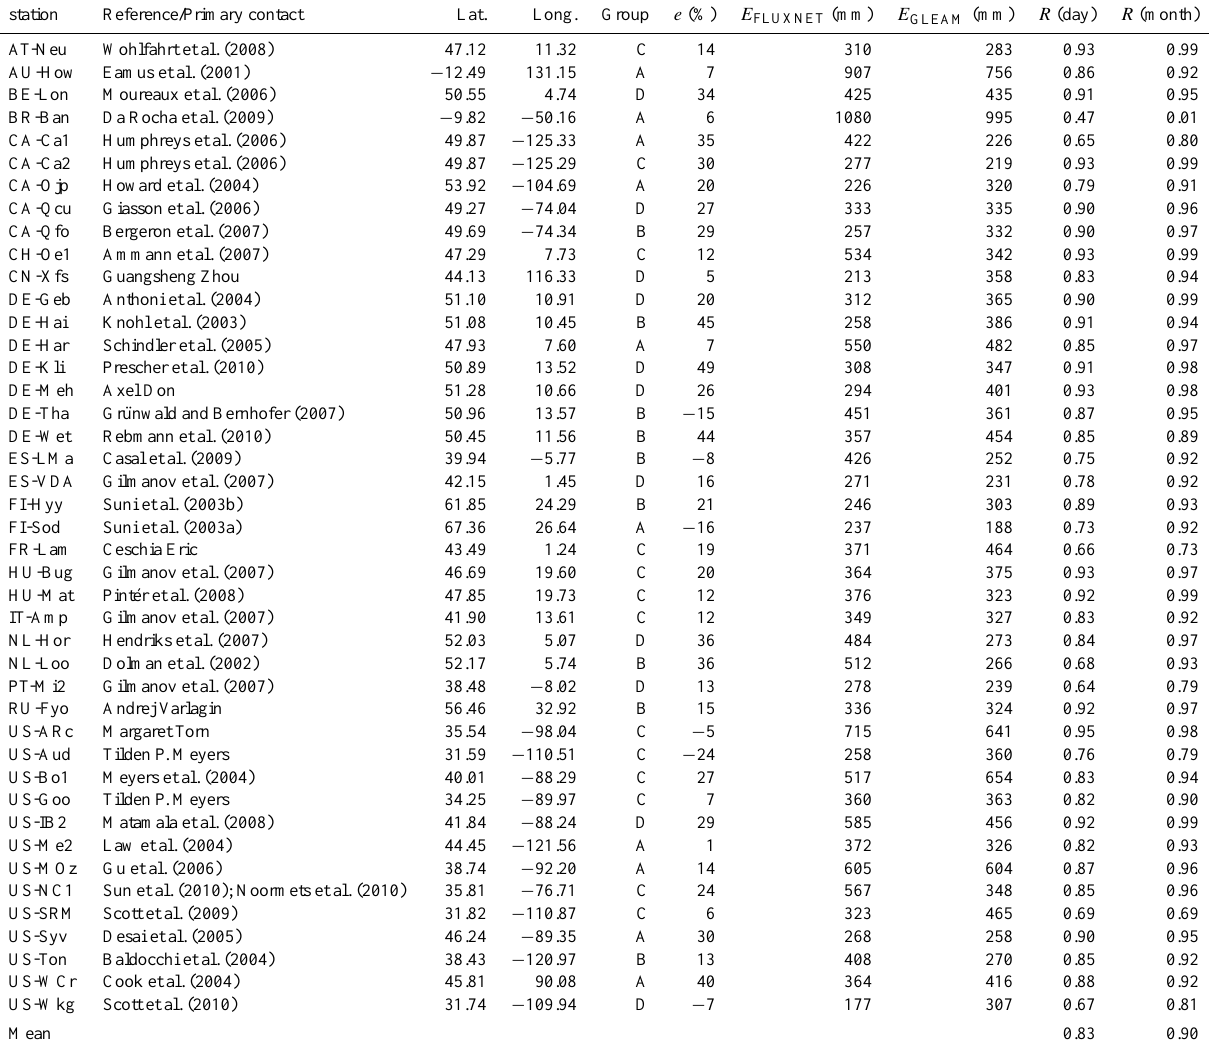
Table 3. FLUXNET sites used in the validation. The coefficient e represents the mismatch in the energy balance at the station. The measured and modelled cumulative evaporation (for 2005) and the correlation coefficients of the comparison at daily and monthly time-step are also listed (in situ R n